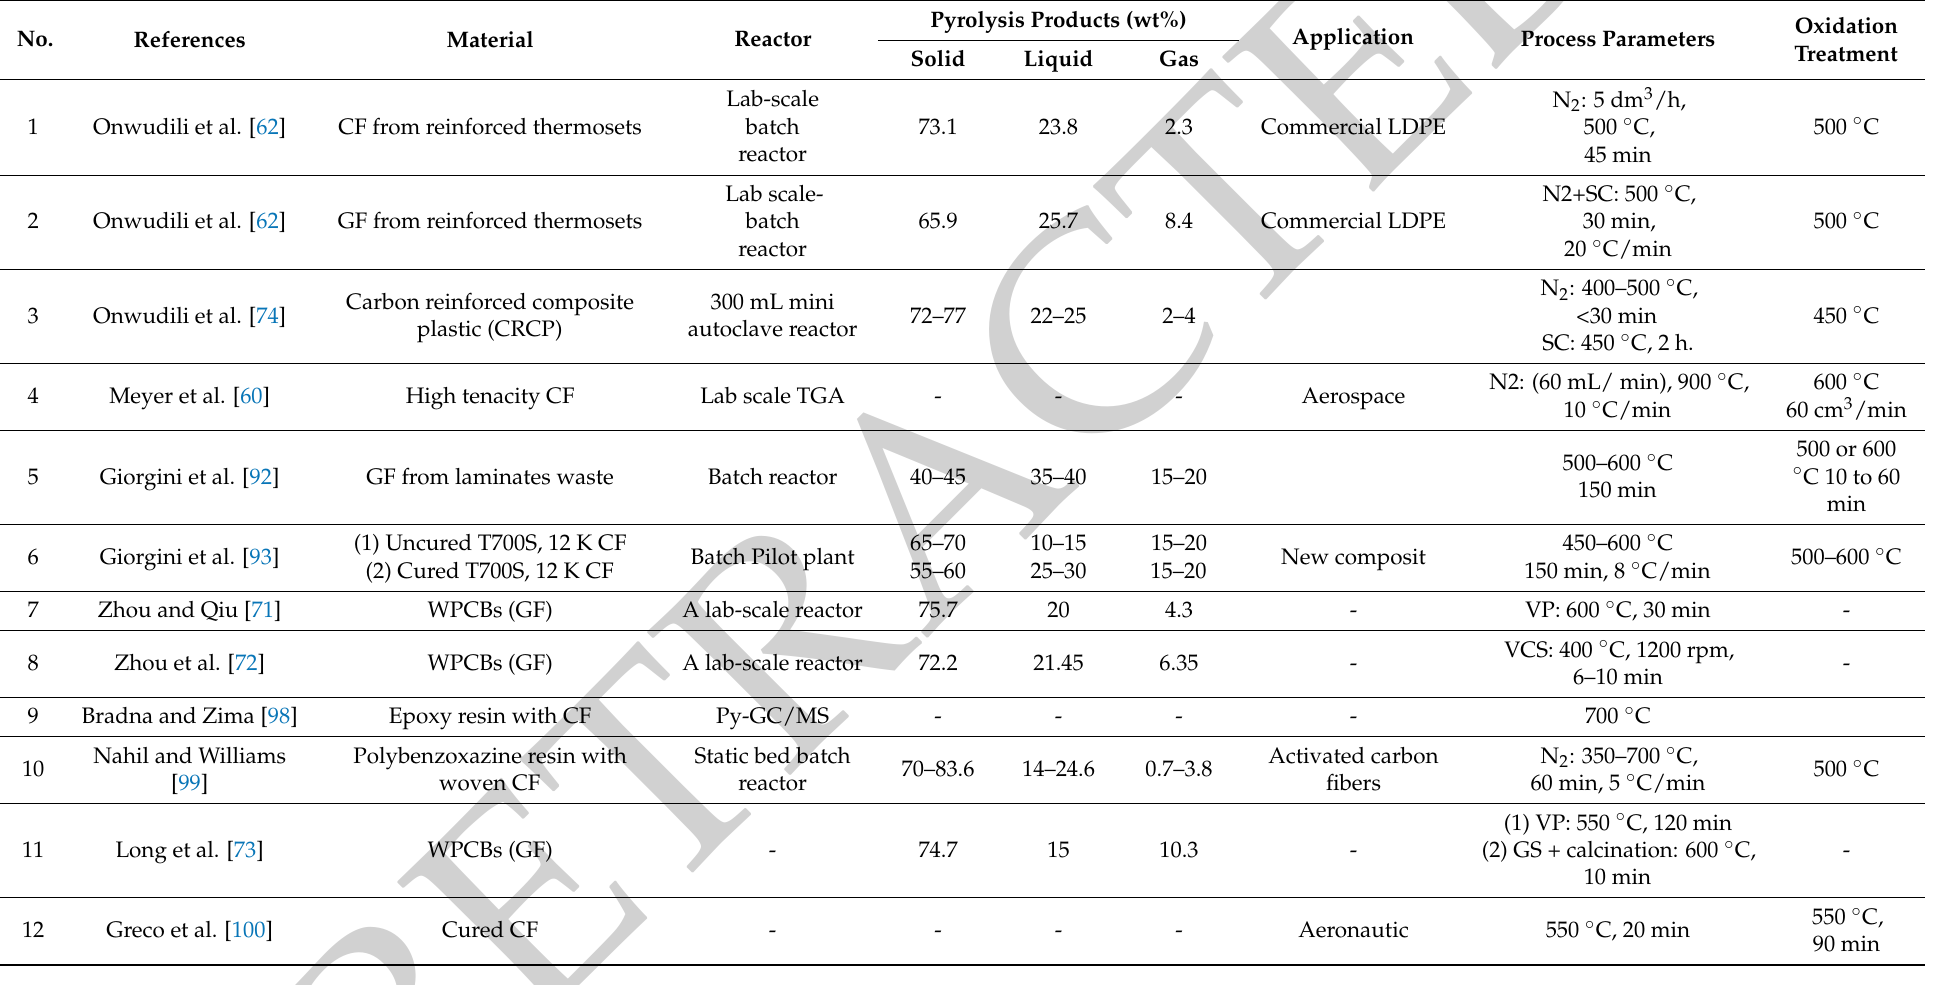
Table 1. GF and CF recovery from composites by